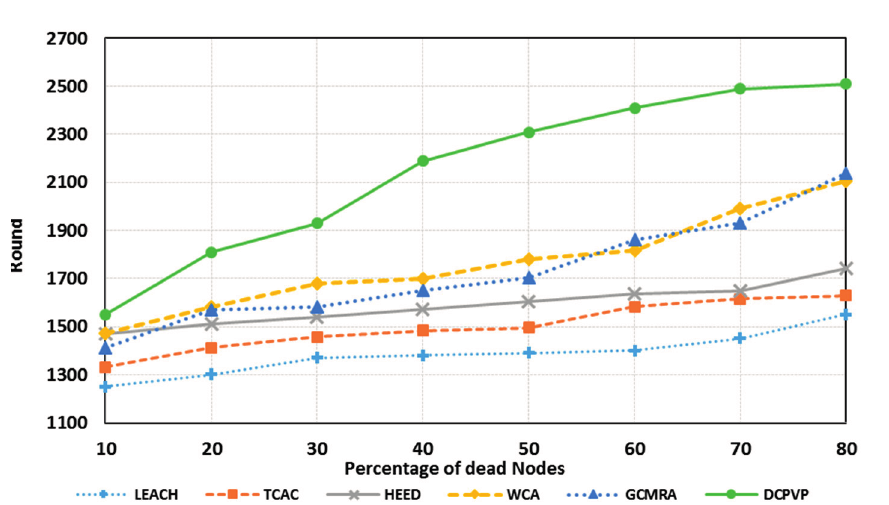
Figure 10. The percentage of dead nodes in uniform distribution for 100 nodes.